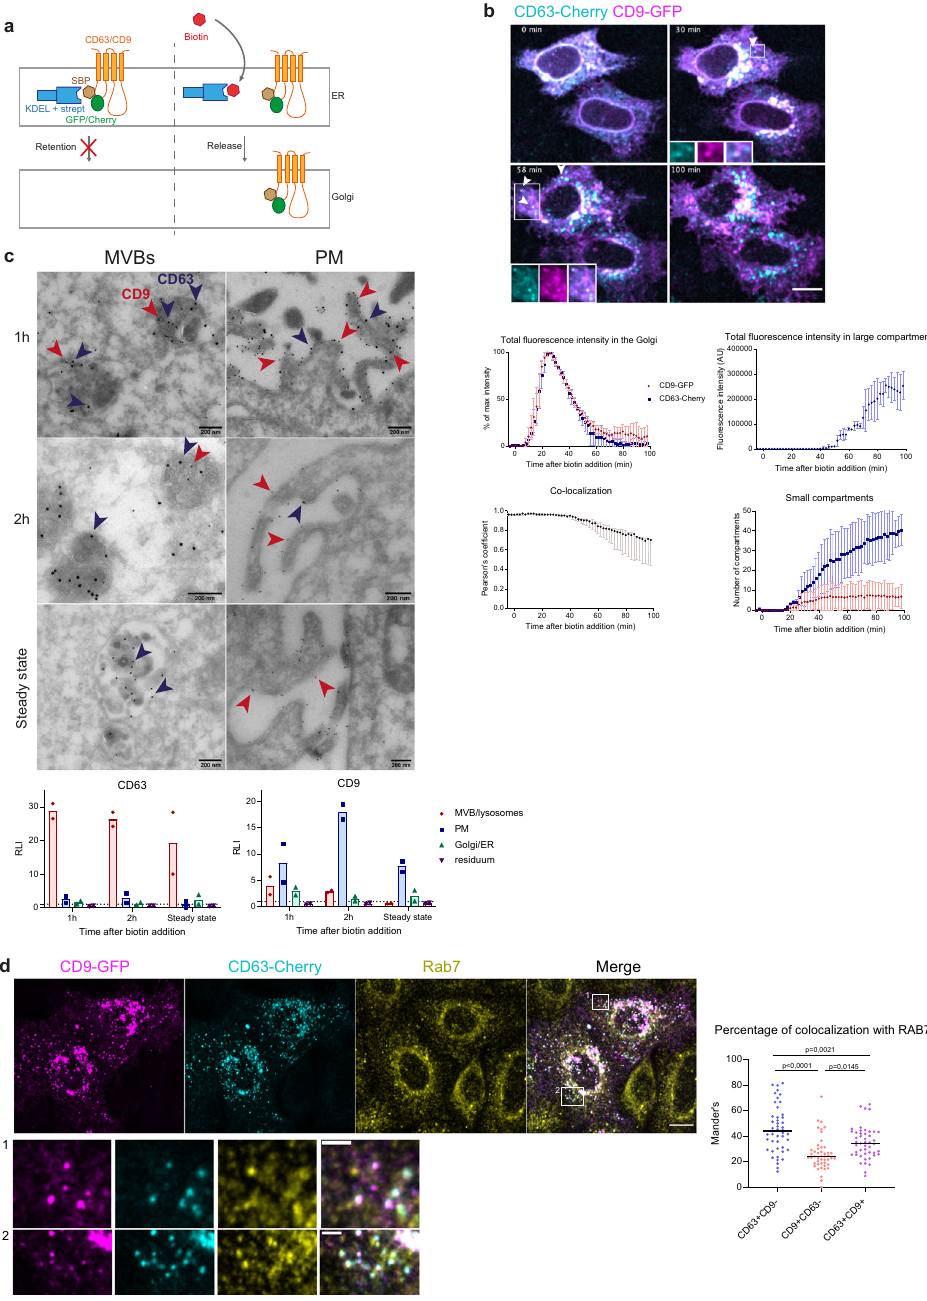
Fig. 2 CD63 and CD9 transiently co-localize in multivesicular bodies and at the plasma membrane. a Principle of the RUSH system used to follow CD63 and CD9 intracellular traf fi cking. SBP streptavidin binding peptide, strept streptavidin, ER endoplasmic reticulum. b Micrographs and quanti fi cations of live imaging of HeLa cells co-transfected with the CD63-mCherry and CD9-eGFP RUSH plasmids. Biotin at 40 μ M was added at T = 0. White arrows show peripheral compartments where CD63 and CD9 co-localize. Z -projection of 11 planes. Scale bar: 5 μ m. Quanti fi cation upon time of three independent experiments showing the mean ± SD eGFP and mCherry fl uorescence intensity in the Golgi and in large compartments, the mean ± SD number of eGFP- or mCherry-positive small compartments and the median and range of the Pearson ’ s co-localization coef fi cient between eGFP and mCherry where automatically quanti fi ed. N = 3 independent experiments. 5 fi elds per experiments where imaged, for a total of at least 10 individual cells to analyze per experiment. c Representative electron microscopy images of HeLa cells co-transfected with RUSH constructs of CD63-mCherry and CD9-eGFP , 1 h or 2 h after incubation with biotin, or at steady-state, labeled with anti-eGFP gold 10 nm (red arrows) and anti-mCherry gold 15 nm (blue arrows). Relative labeling index (RLI) in each compartment quanti fi ed from 7 different fi elds per replicate is represented as mean ( n = 2 independent biological replicates). d Confocal microscopy pictures of HeLa cells ( z -projection) co-transfected with CD63-mCherry- and CD9-eGFP- RUSH plasmids, and stained with anti-Rab7 after 1 h of incubation with biotin. Scale bar: 10 μ m. Mander ’ s coef fi cients representing the % of CD9 + /CD63-, CD9-/CD63 + , and CD9 + /CD63 + intracellular compartments also positive for the Rab7 signal in each cell are shown. Results from two independent experiments are shown, each dot represents one cell (23 cells from replicate 1, and 24 cells from replicate 2) and the median is represented. Ordinary one-way ANOVA with a Tukey ’ s multiple comparisons test was performed to compare the different categories of intracellular compartments shown on the